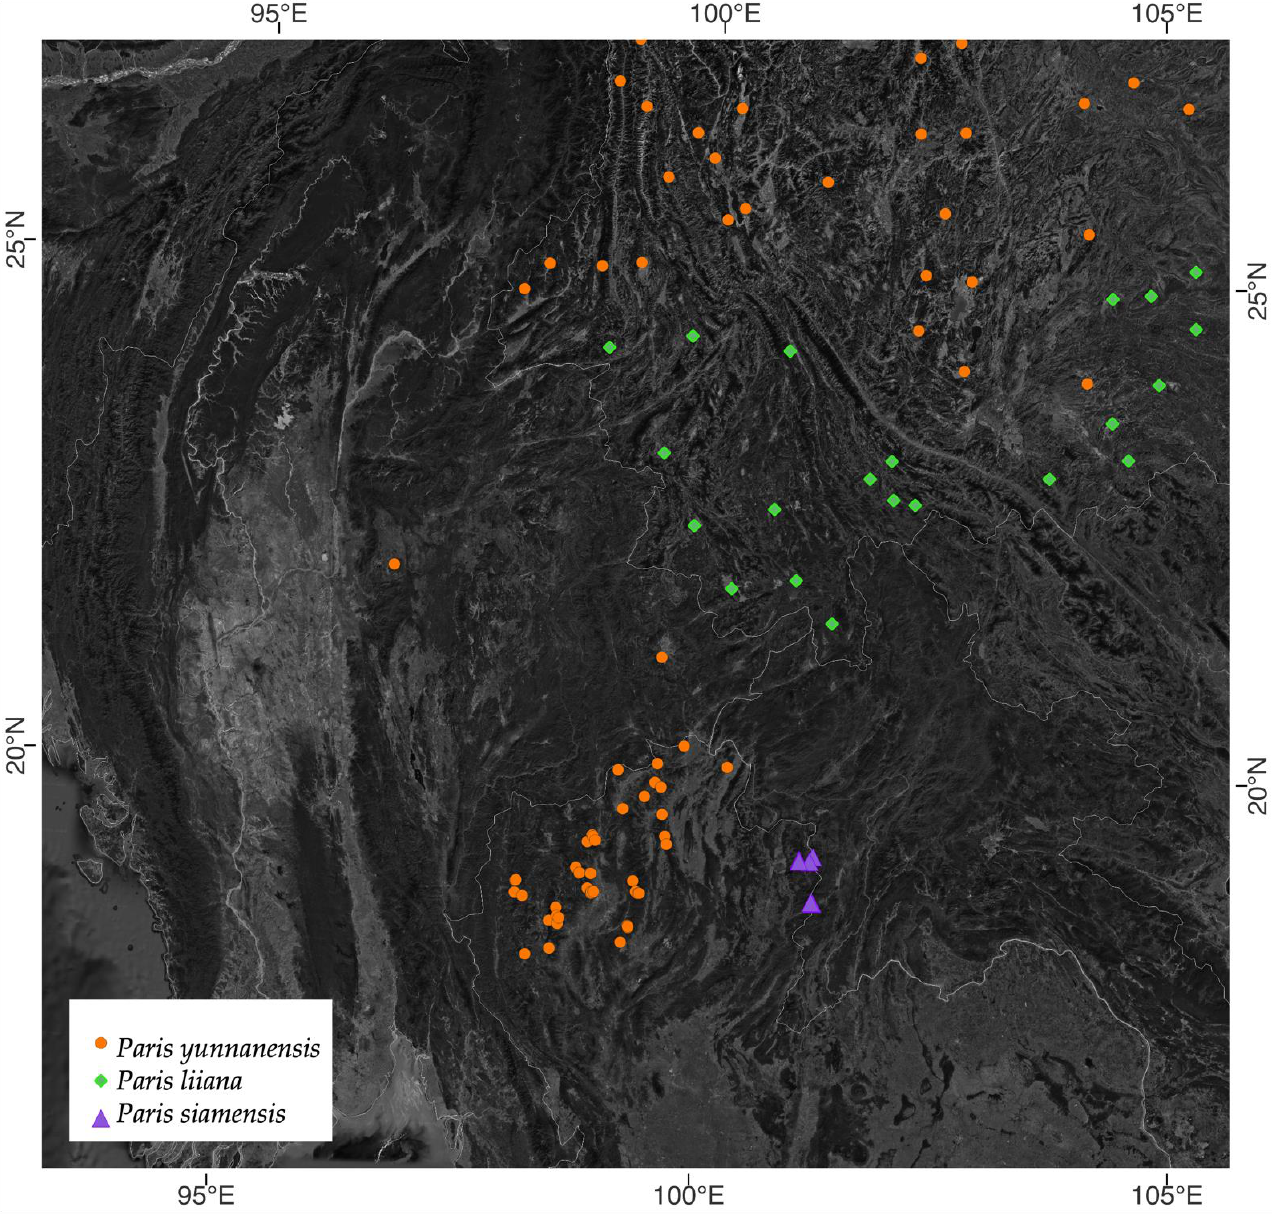
Figure 4. The distribution map of P. yunnanensis , P. liiana , and P. siamensis .